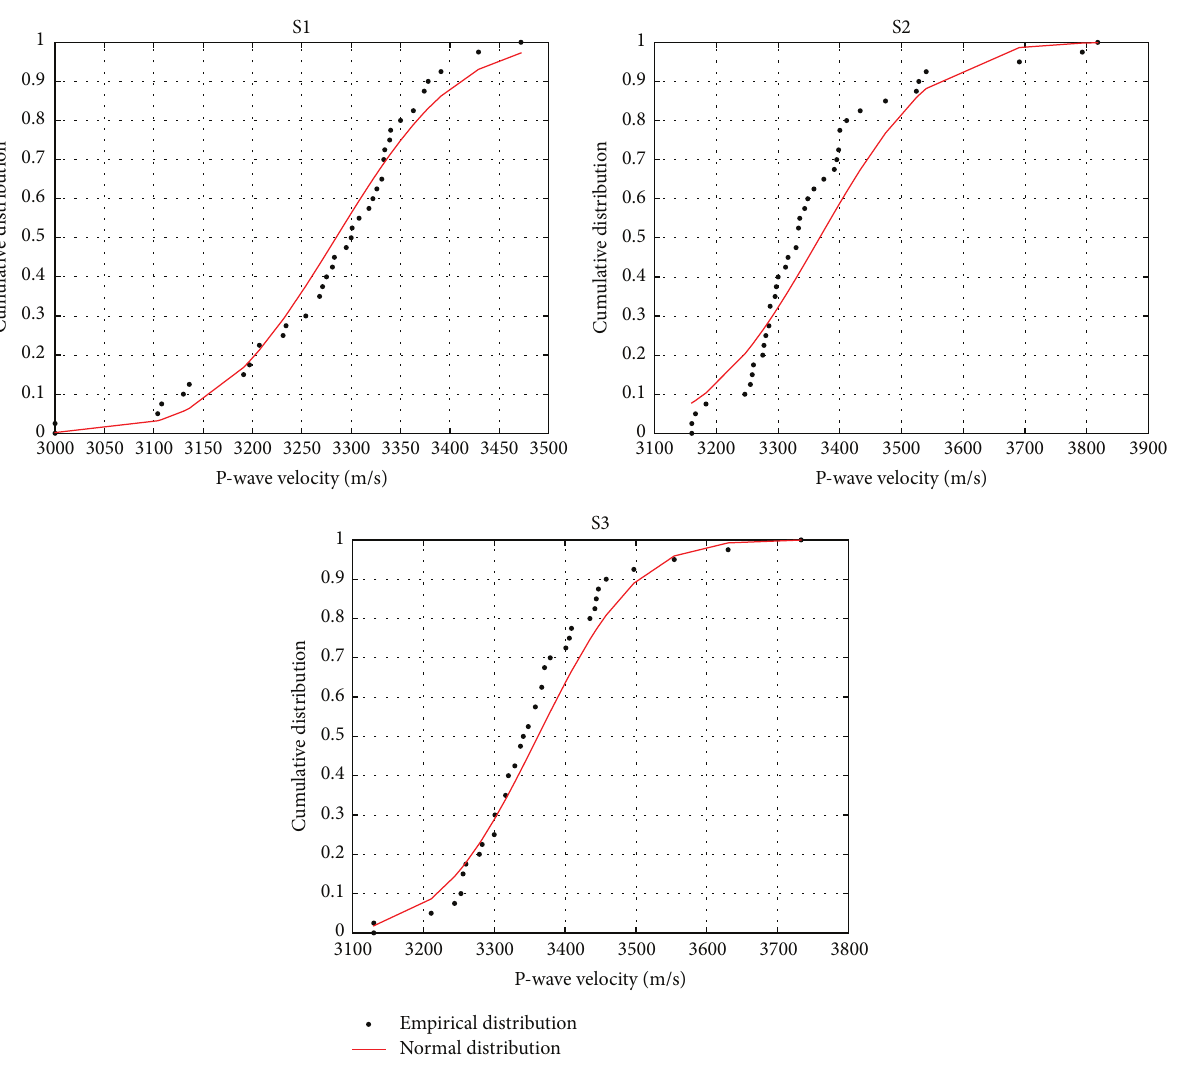
Figure 17: Cumulative normal distribution function of P-wave